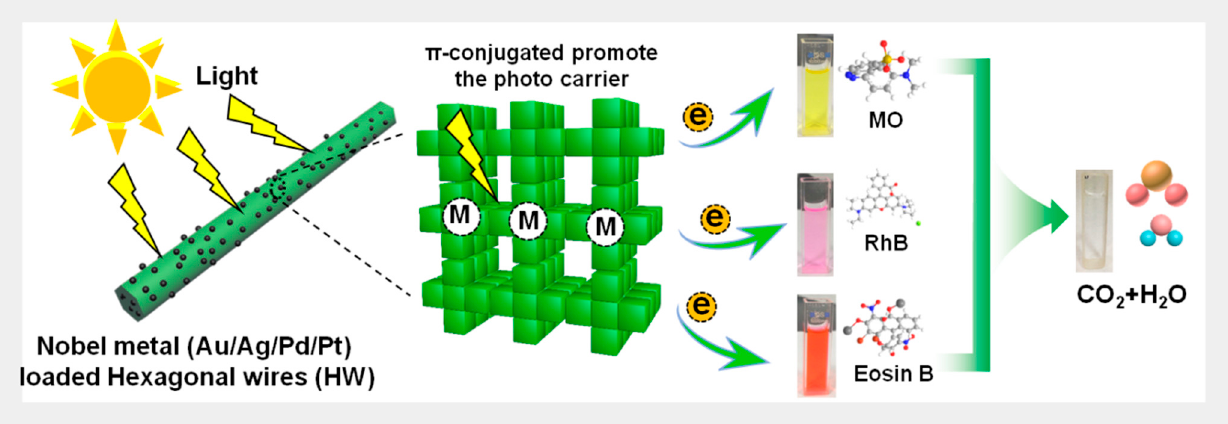
Figure 1. The schematic image of the photodegradation of different organic pollutants using one- dimensional M-HW nanocomposites.